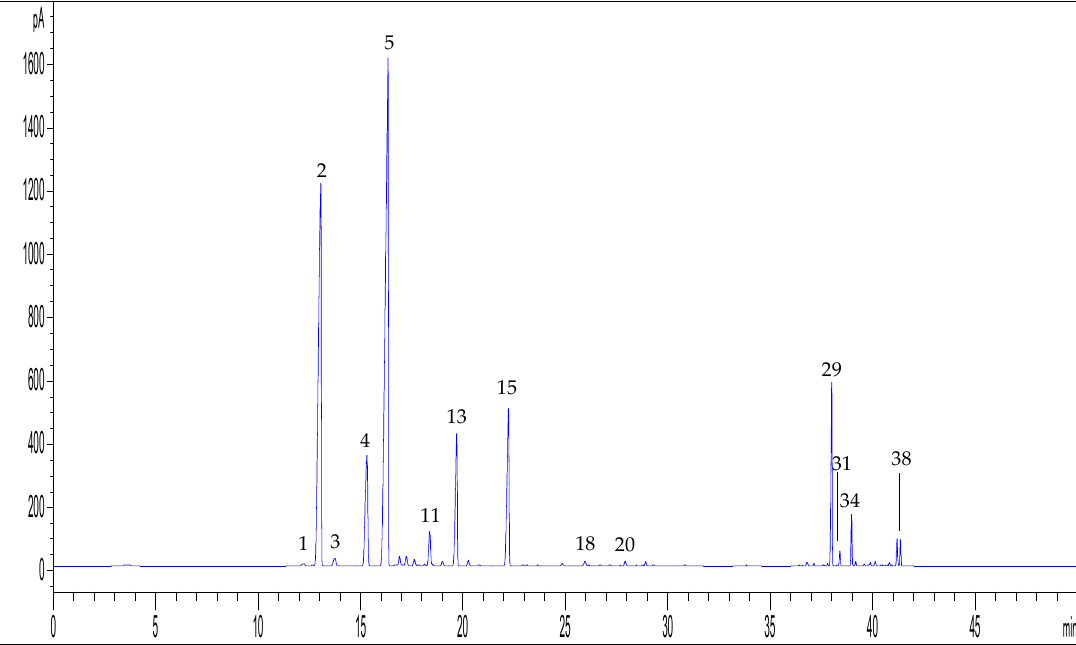
Molecules 2018 , 23 , x; doi: FOR PEER REVIEW